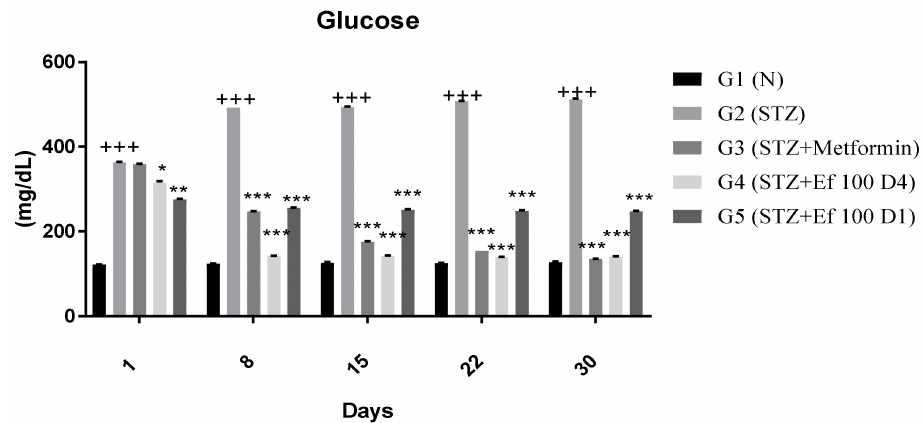
Figure 2. Effects of different treatments on blood glucose levels (mg/dL) in different experimental groups. Day 1: the day of the STZ injection, G1: normal, nondiabetic rats treated with normal saline solution orally, G2: diabetic rats treated with normal saline solution orally, G3: diabetic rats treated with metformin (100 mg/Kg) orally starting from Day 4, G4: diabetic rats treated with Ephedra foeminea extract (100 g/kg) orally starting from Day 4, G5: diabetic rats treated with Ephedra foeminea extract (100 g/kg) orally from Days 1 to 4. Bars represent the mean of the glucose concentration ± SD of 6 rats. Blood glucose levels were significantly decreased in induced diabetic rats treated with metformin (G3) and Ephedra foeminea extract (G4 and G5) compared to the untreated induced diabetic rats’ group (G2). The results are expressed as means ± SD ( n = 3–4 dependent replicates). *: p < 0.05, **: p < 0.01, ***: p < 0.001 compared to G2: diabetic rats, +++: p < 0.001 compared G1: nondiabetic rats. The result were analyzed using one way ANOVA.